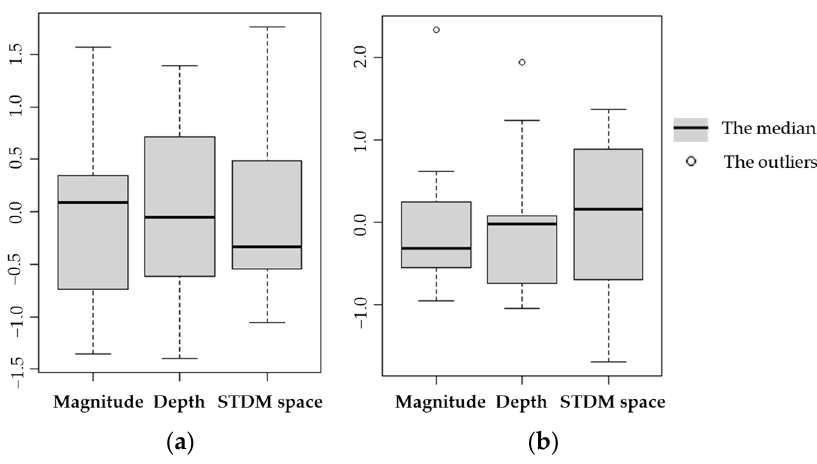
Figure 10. ( a ) Boxplot for the medium EDRI ( b ) Boxplot for the high EDRI.